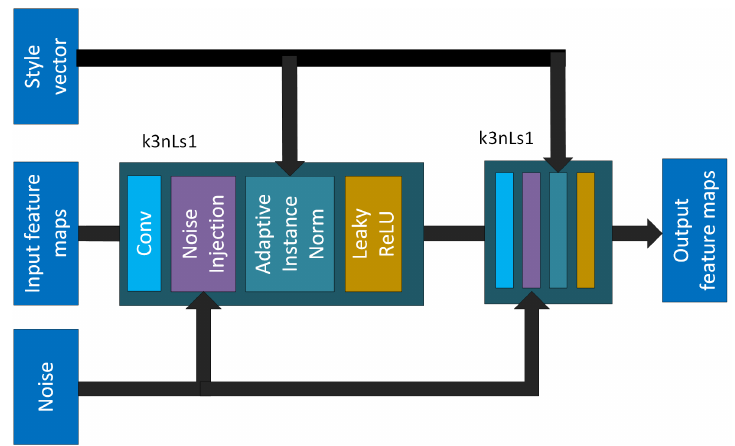
Figure A1. The StyledConvBlock with L output channels in the generator. In each block, the parameters of the convolution layer are: k is the kernel size, n is the number of channels and s is the stride for each convolutional layer. Table A1. The cStyleGAN generator.